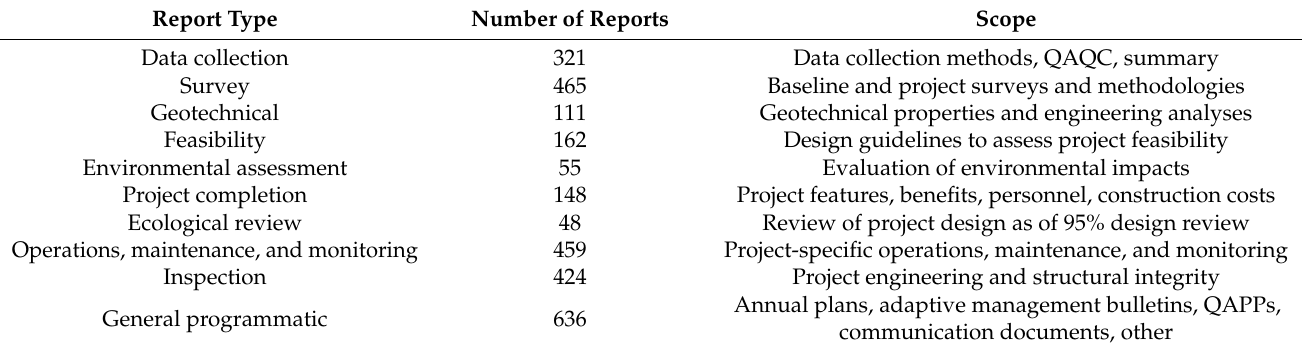
Table 1. Project, programmatic, and synthesis reports developed since 1980 in support of coastal Louisiana risk reduction and restoration